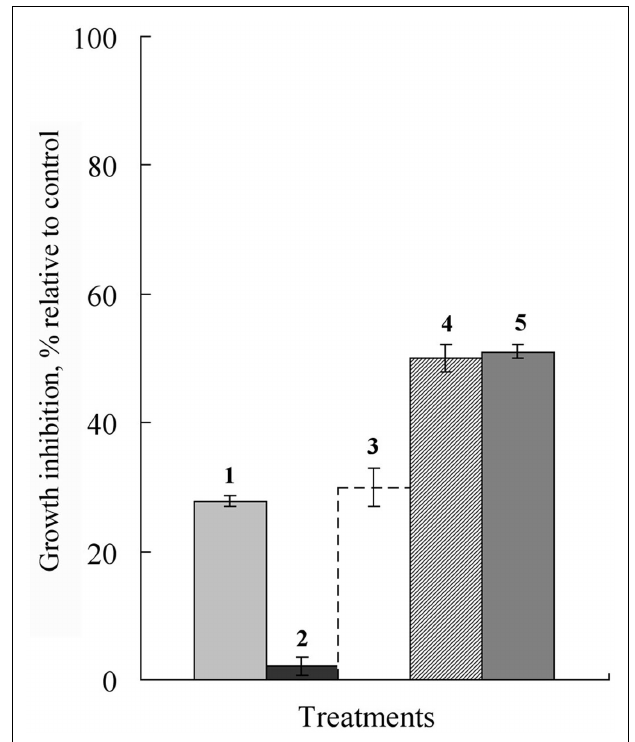
FIGURE 4 | Histograms showing percent growth inhibition of thymol, Folicur and their combinations, on A. alternata growth after 10-day cultivation. ( 1) Folicur, 0.5ppm alone; ( 2) thymol, 10ppm alone; ( 3) predicted growth inhibition based on sum of 1 and 2 ; ( 4) Folicur, 0.5ppm with thymol, 10ppm; ( 5) Folicur, 1.0ppm. Distinctions of all treatments from the control, and between Folicur and Folicur + thymol treatments are significant at p ≤ 0.0001. Bars indicate SE.